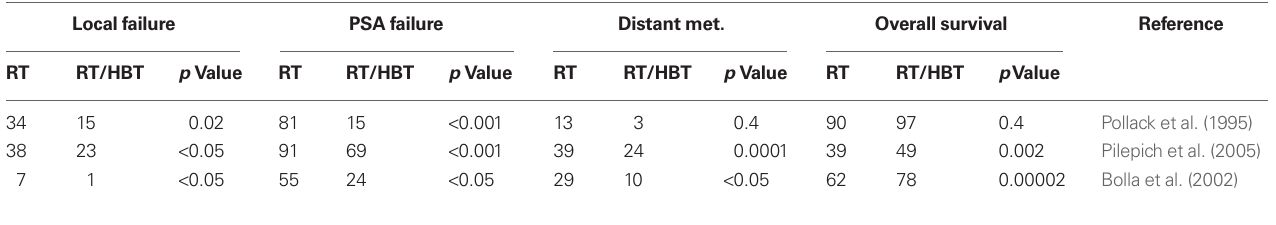
Table 2 | Comparison of treatment outcomes of short-term HBT (SHRT) and RT with long-term HBT and RT (LHRT; percentage). Local failure PSA failure Distant met. Overall